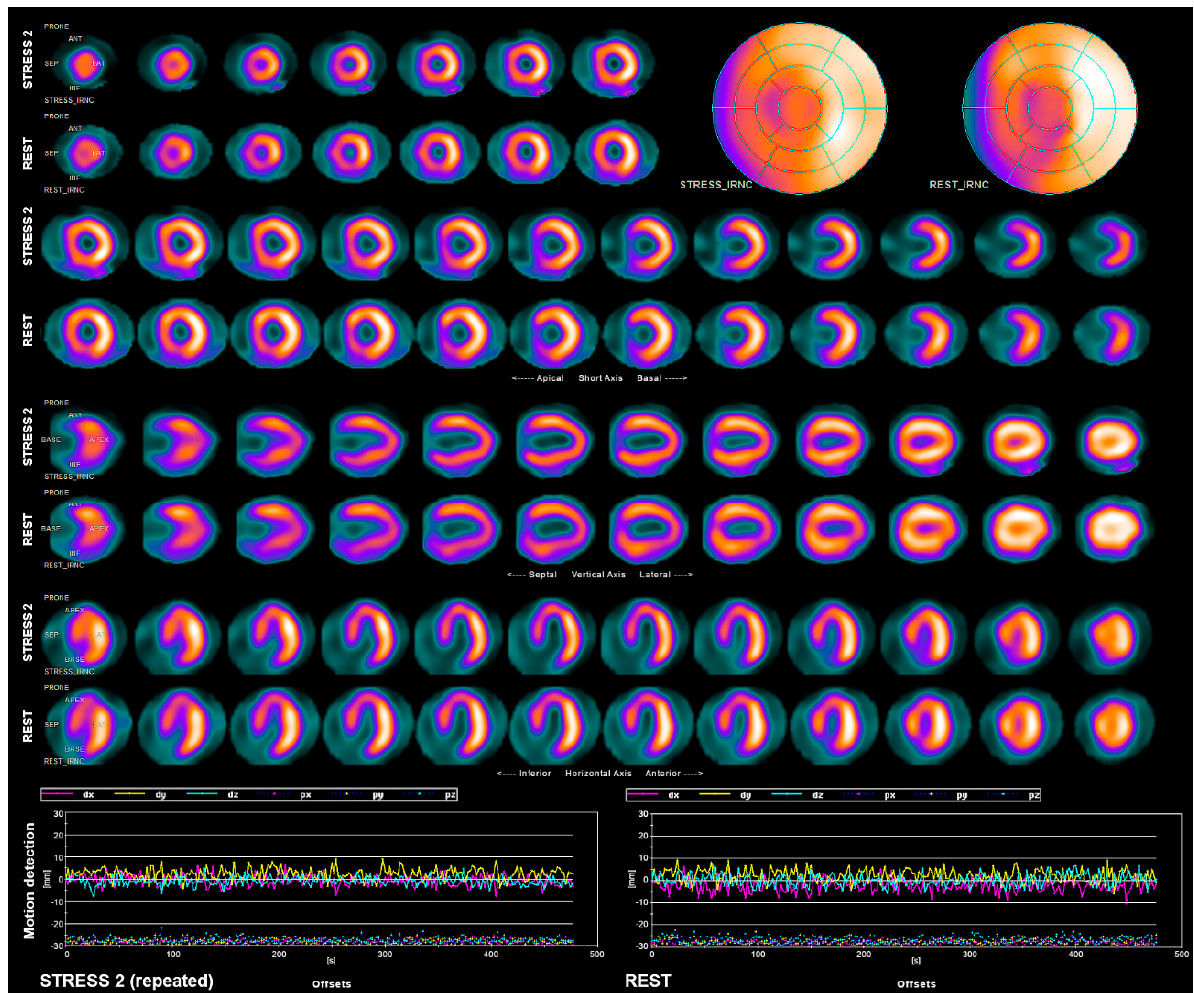
Figure 2. Stress acquisition was repeated with fixed mask position (~20 min after the first study), without any notable artifacts. Evaluation of the repeated study revealed no features of stress-induced ischemia. The only finding was a mild, fixed perfusion defect in an area of an apex and inferoseptal wall of LV, more pronounced in the rest study, which is common in LBBB [1,2]. Discovery NM 530c camera is susceptible to motion-related artifacts [3]. In normal circumstances, short acquisition time minimizes their likelihood and impact [4–6]. However, in times of the pandemic, mandatory masks can cause discomfort and breathing difficulties, which can increase the incidence and severity of motion artifacts. Motion detection on this camera is more difficult and time-consuming compared to traditional cameras [7] and requires additional data processing. For this reason, it is not performed routinely for every study. However, it is advised to perform it at least whenever a significant difference between perfusion in stress and rest studies is observed, especially when study result does not agree with the patient’s condition. Nuclear medicine technologist plays a major role in proper acquisition of the study and should ensure comfortable positioning of the patient, including the position of the face mask, to avoid such artifacts. Technologist should also closely monitor the patient and inform the physician if any patient motion occurred during the study, as motion detection procedure is not performed routinely, unlike in case of traditional SPECT gamma cameras. As shown in this case, mask-related motion artifacts can generate a false-positive MPS result that would qualify the patient for an unnecessary invasive study: coronary